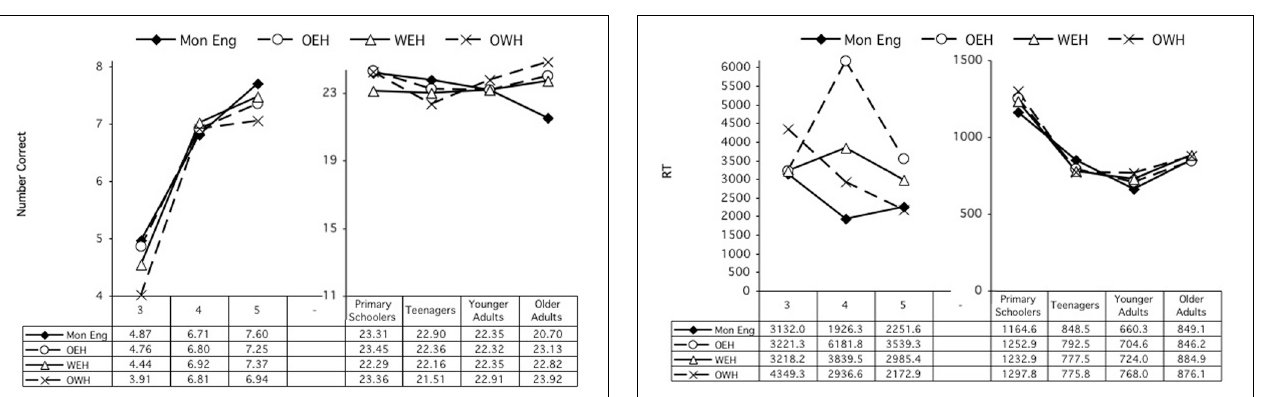
FIGURE 5 | Simon task: RT by age and home language, congruent condition.